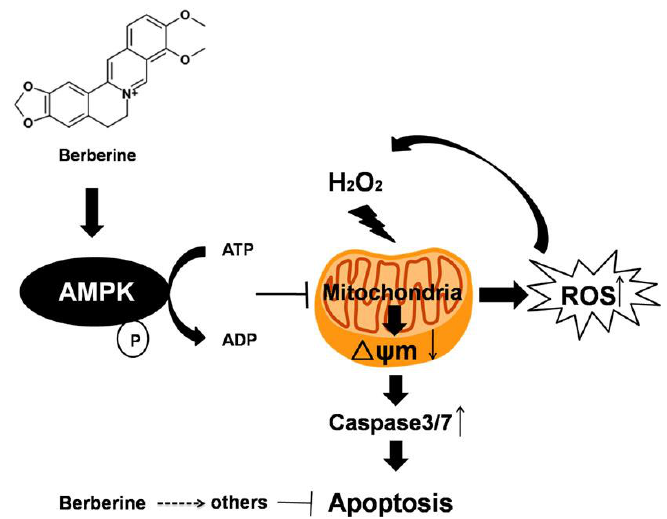
Figure 9. The possible mechanism of Berberine.